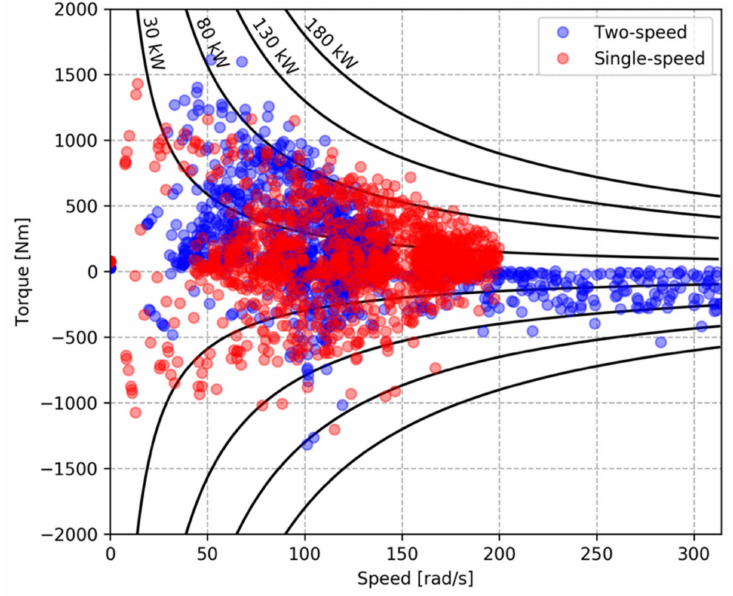
Figure 8. Comparison of operating points of the motor